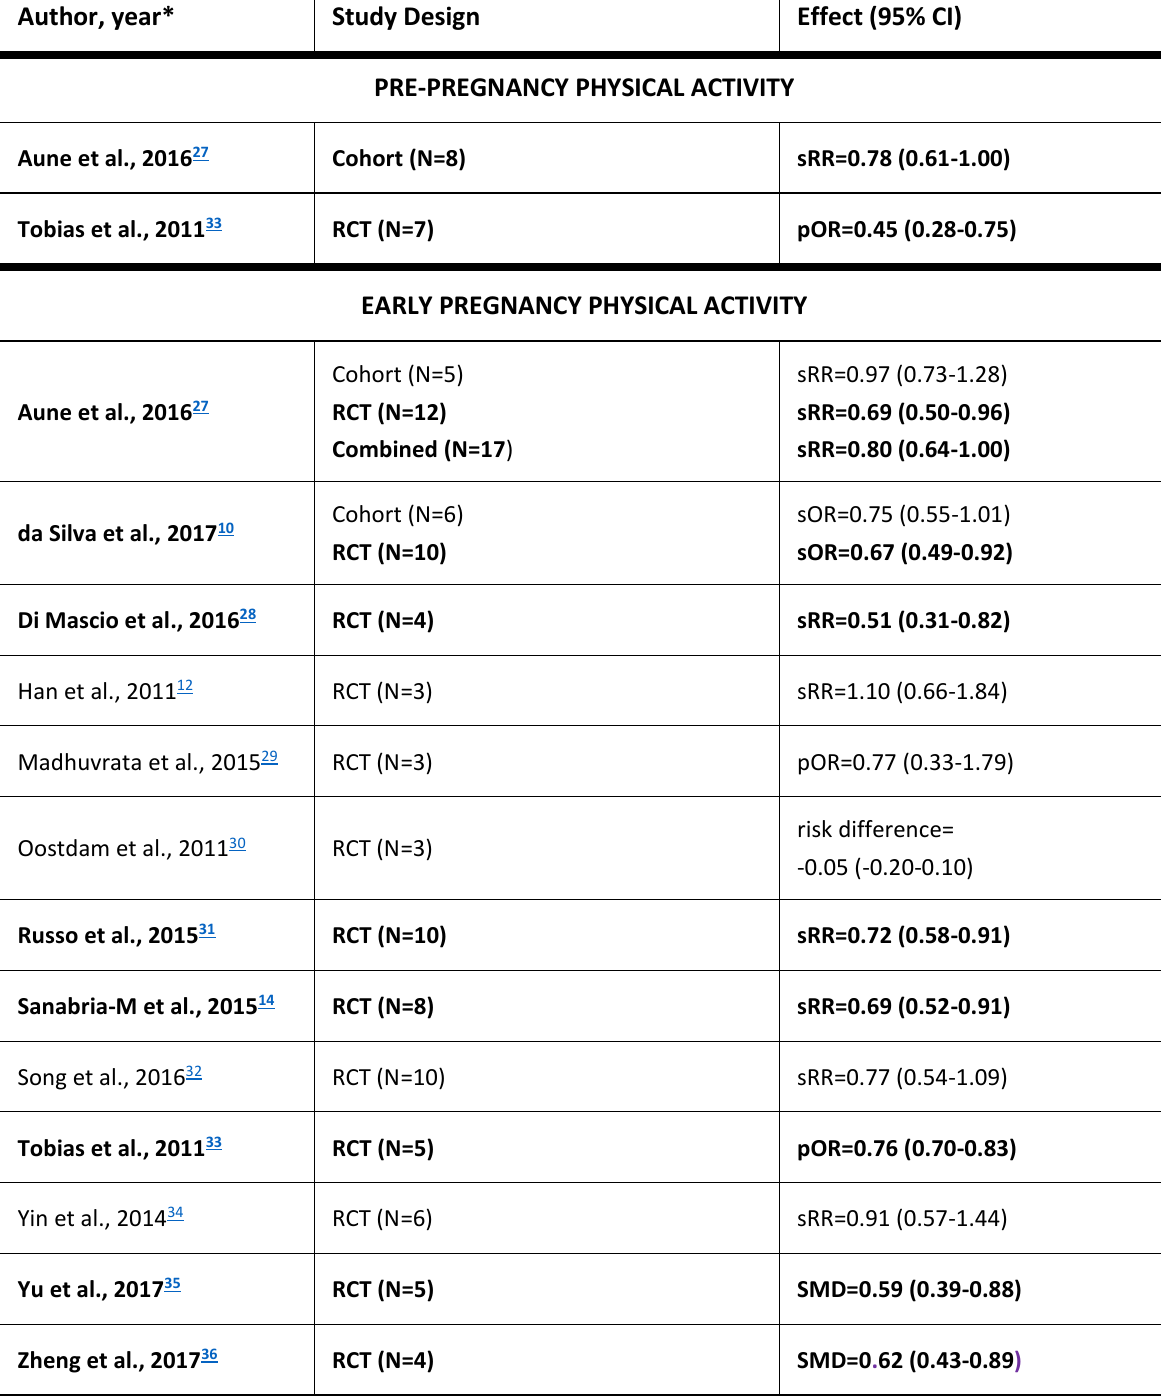
Table F8-1. Summary of Findings from 13 Meta-Analyses of the Relationship Between